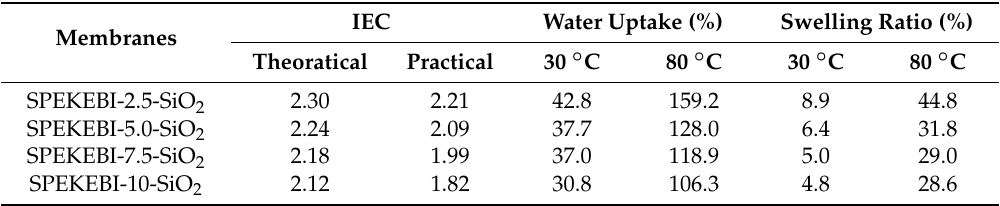
Table 1. Ion-exchange capacities (IECs), water uptake and swelling ratio of SPEKEBI-x-SiO 2 and SPEKEBI membranes.